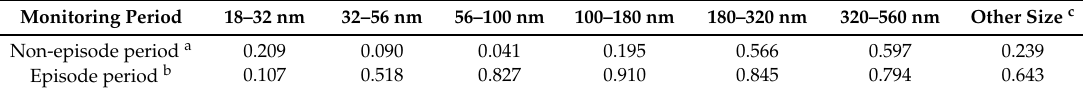
Table 3. Pearson correlation coefficients between the BC mass and particle number concentrations for seven selected size ranges during the corn straw open-field burning period and the same period on the reference